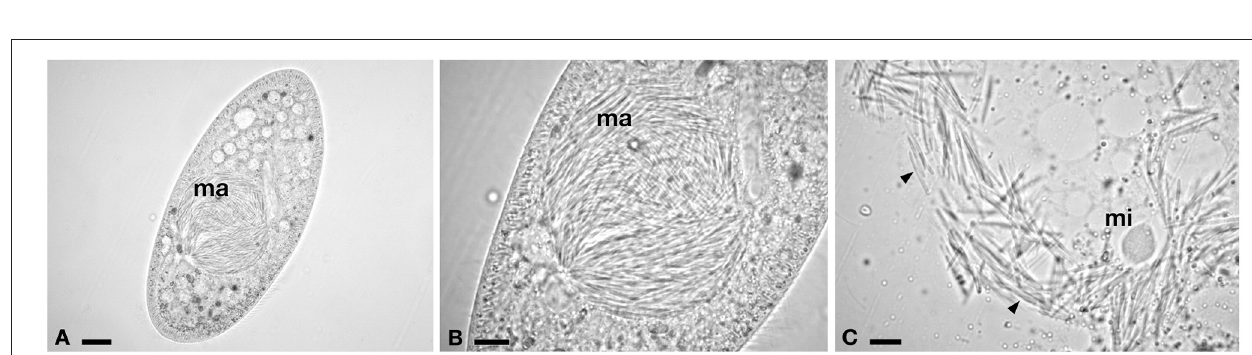
FIGURE 2 | Light microscopy and FISH analyses of infected P. jenningsi BJ1. (A) Cell with hyperinfected macronucleus ( ma ). (B) Infected ma and three chromosomal type micronuclei ( mi ). (C) Detail of reproductive, infectious and transient forms, after ma crushing. (D) Positive signal of the probe GortProb659 (labeled with Cy3, emitting in red) inside host ma , during FISH experiment. Arrowheads indicate infectious forms, arrows reproductive forms and double arrowheads transient forms. Bars stand for 10 µ m (A,D) and 5 µ m (B,C) .